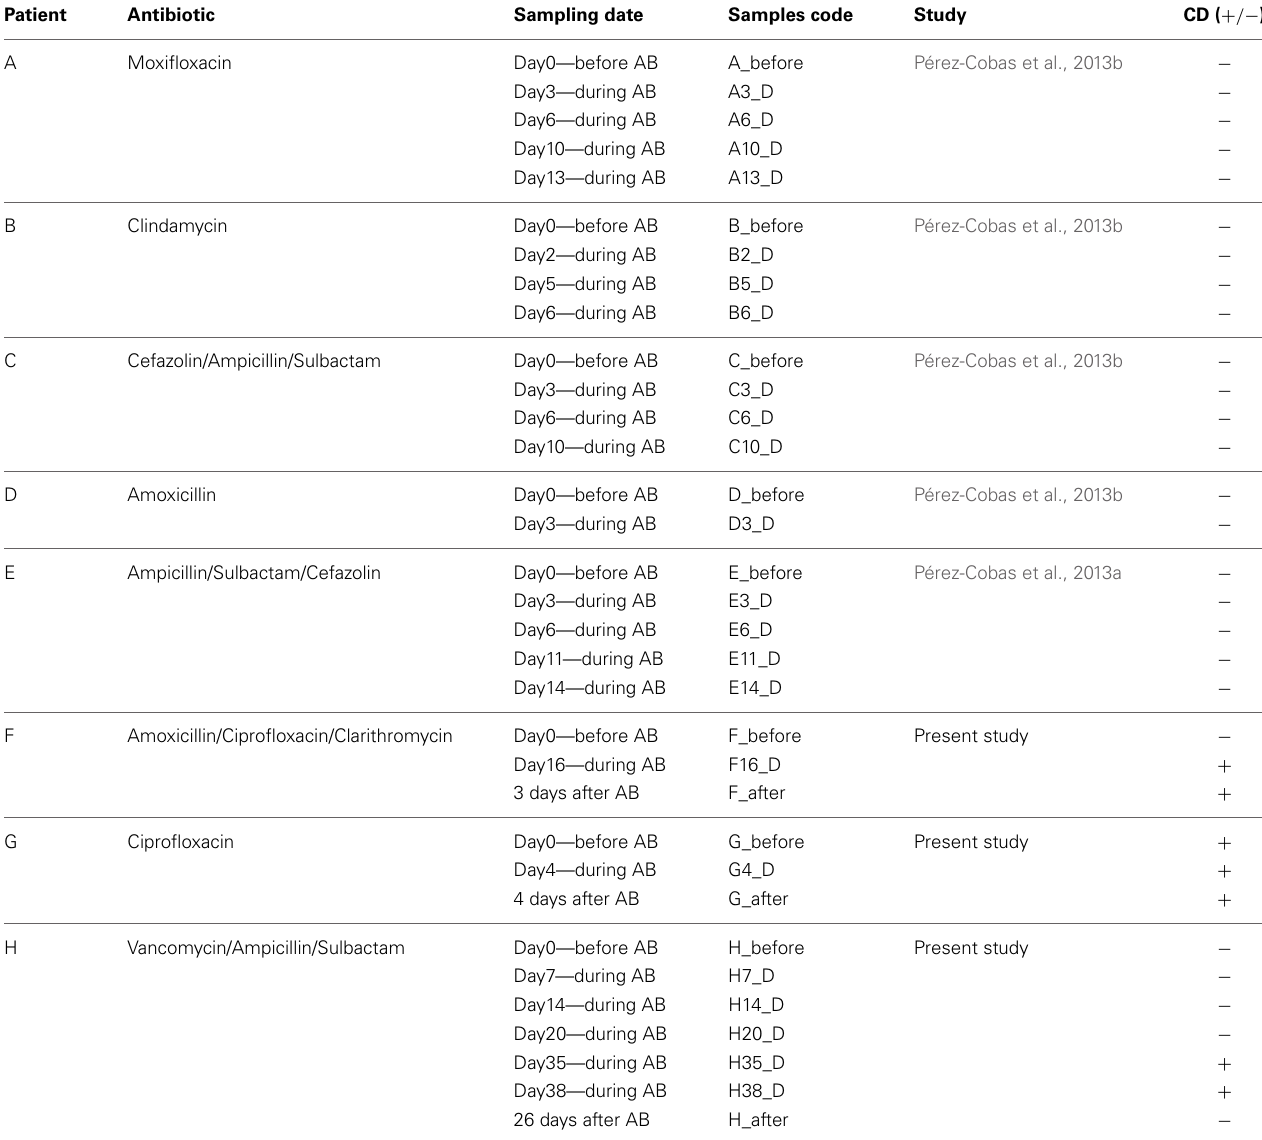
Table 1 | Description of the patients involved in the